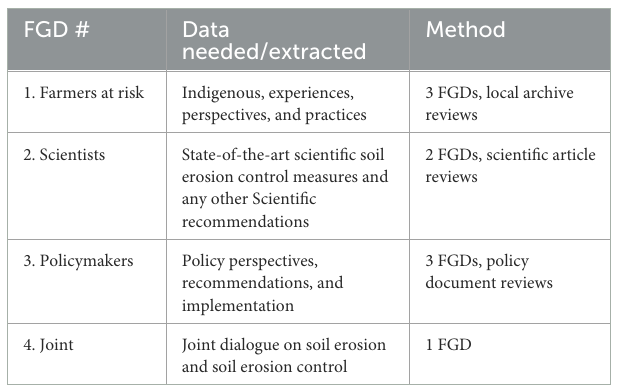
TABLE 1 Details about the data collection.